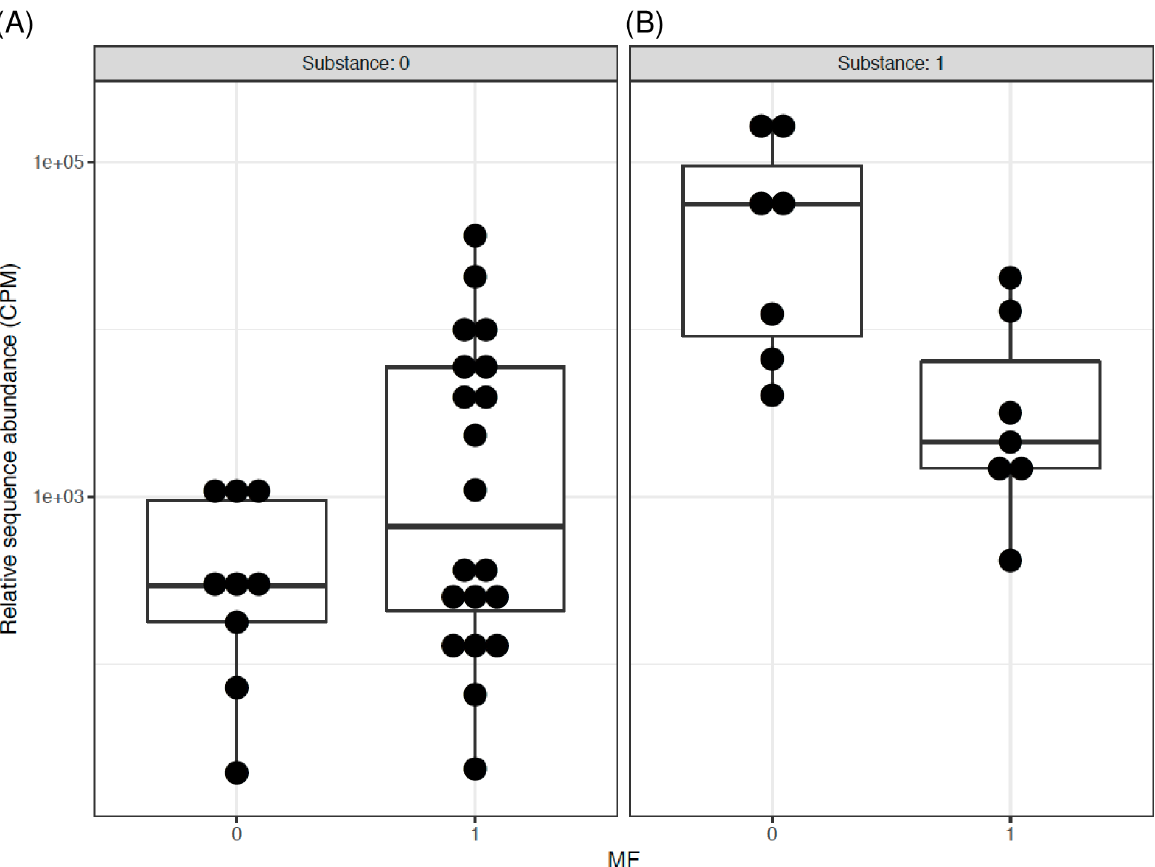
Fig 6. The interactive influence of opioids on Bifidobacterium genus in men with T2D and taking or not taking metformin. Data and analysis are the same as in Fig 5. (A) 3.17 log2 fold increase in Bifidobacterium in men taking vs. not taking metformin when both groups are not opioid users (q = 0.03). (B) 3.67 log2 fold decrease in Bifidobacterium in men taking vs. not taking metformin when both groups are opioid users (q =